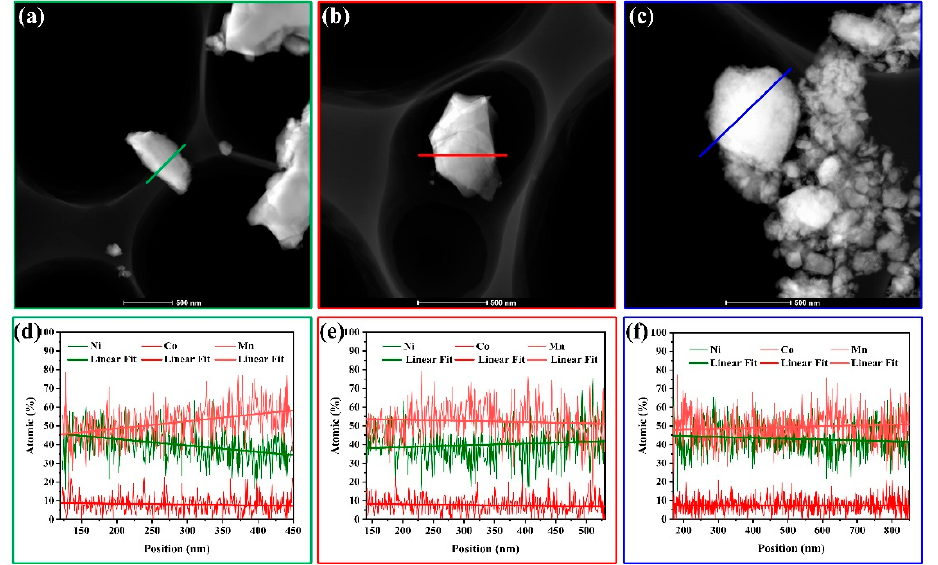
Figure 4. TEM images and X-ray line scan element distribution (EDX) maps: ( a , d ) SLC; ( b , e ) SLS; ( c , f ) OCP.